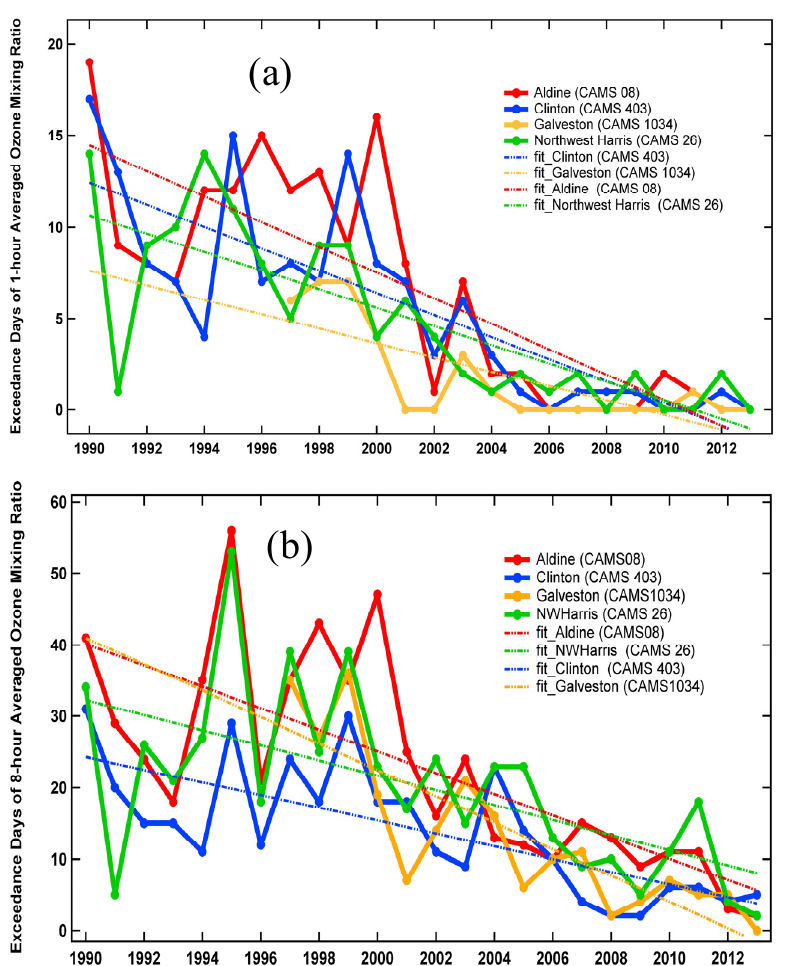
Figure 2. Annually exceedance days of 1-h averaged ( a ) and 8-h averaged ( b ) O 3 mixing ratios during 1990–2014 for four